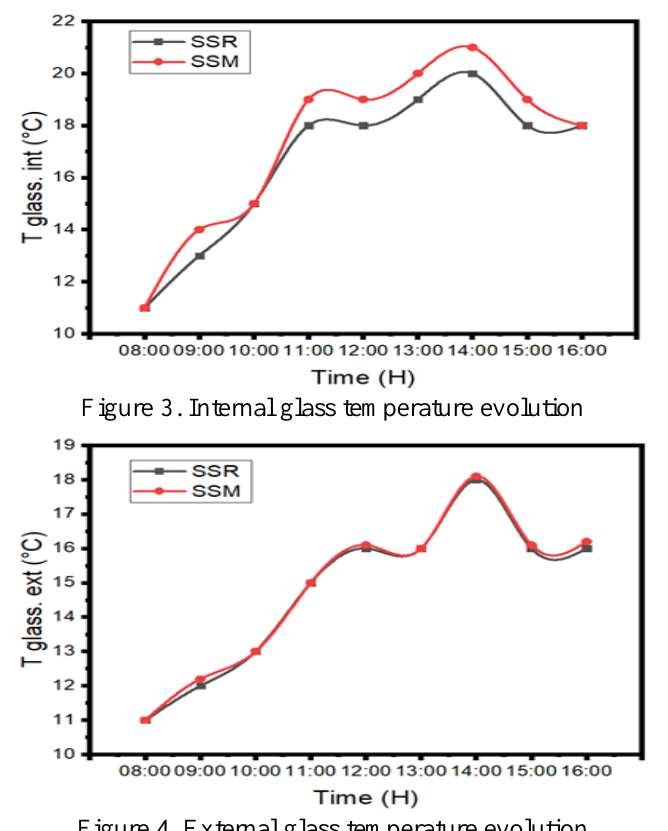
Figure 4. External glass temperature evolution